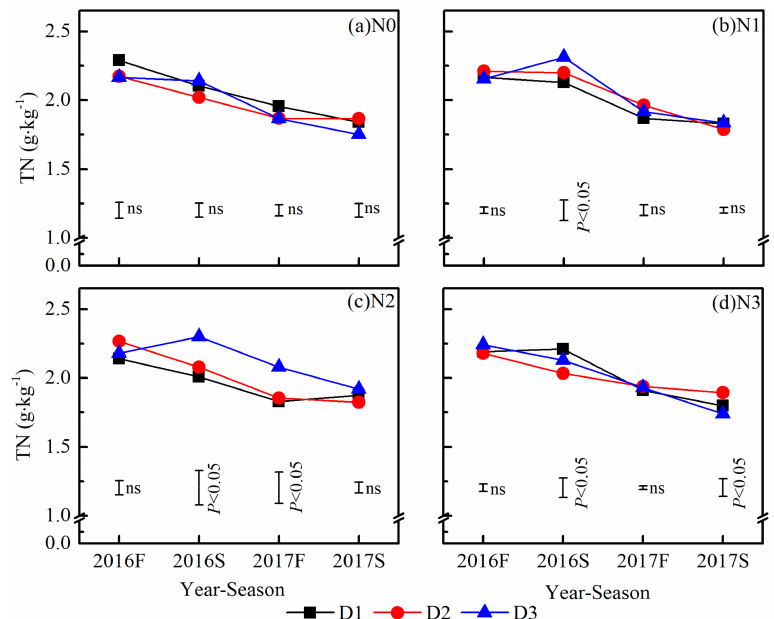
Figure 6. Soil total nitrogen (TN) of different treatments. ( a ) soil total nitrogen in 2016F. ( b ) soil total nitrogen in 2016S. ( c ) soil total nitrogen in 2017F. ( d ) soil total nitrogen in 2017S. 2016F, the first season of 2016 (transplanting season). 2016S, the second season of 2016 (regrowth season). 2017F, the first season of 2017 (regrowth season). 2017S, the second season of 2017 (regrowth season). Vertical bars represent the standard error for different treatments. p < 0.05 represent a significant difference among other therapies, and ns mean no difference among treatments.